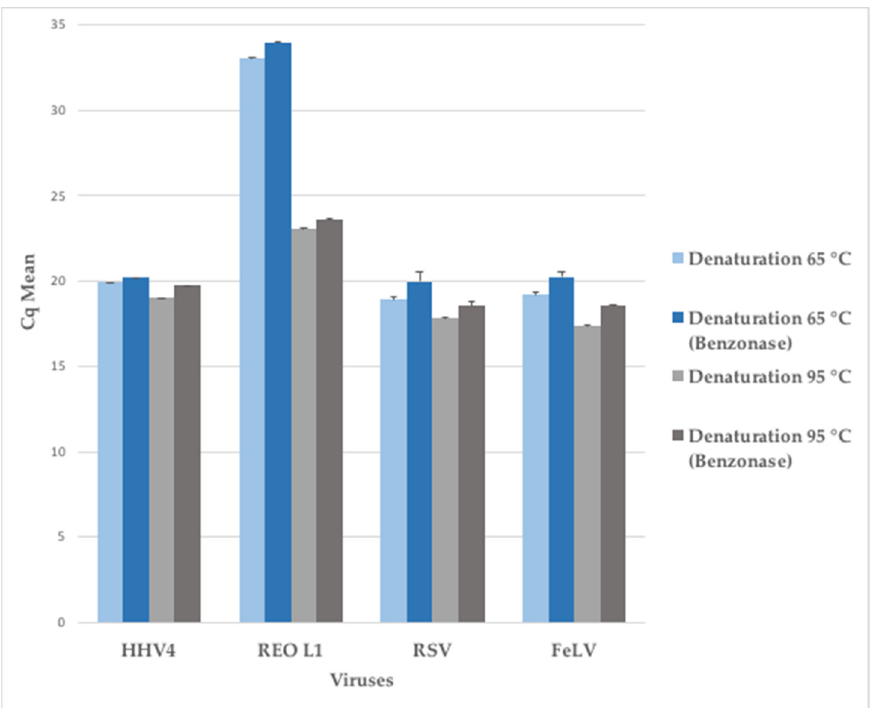
Figure 6. Effect of denaturation temperature of dsRNA virus prior to reverse-transcription on the treated sample with or without benzonase. Each viral stock (HHV-4, REO L1, RSV, FeLV) was diluted to 5 × 10 6 genome-copies per mL for the NA isolation.